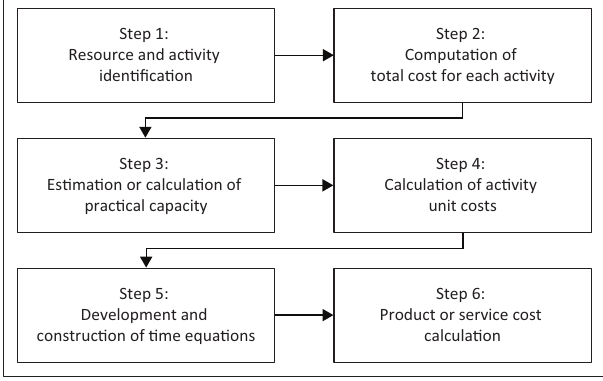
FIGURE 1: Generic steps for time-driven activity-based costing